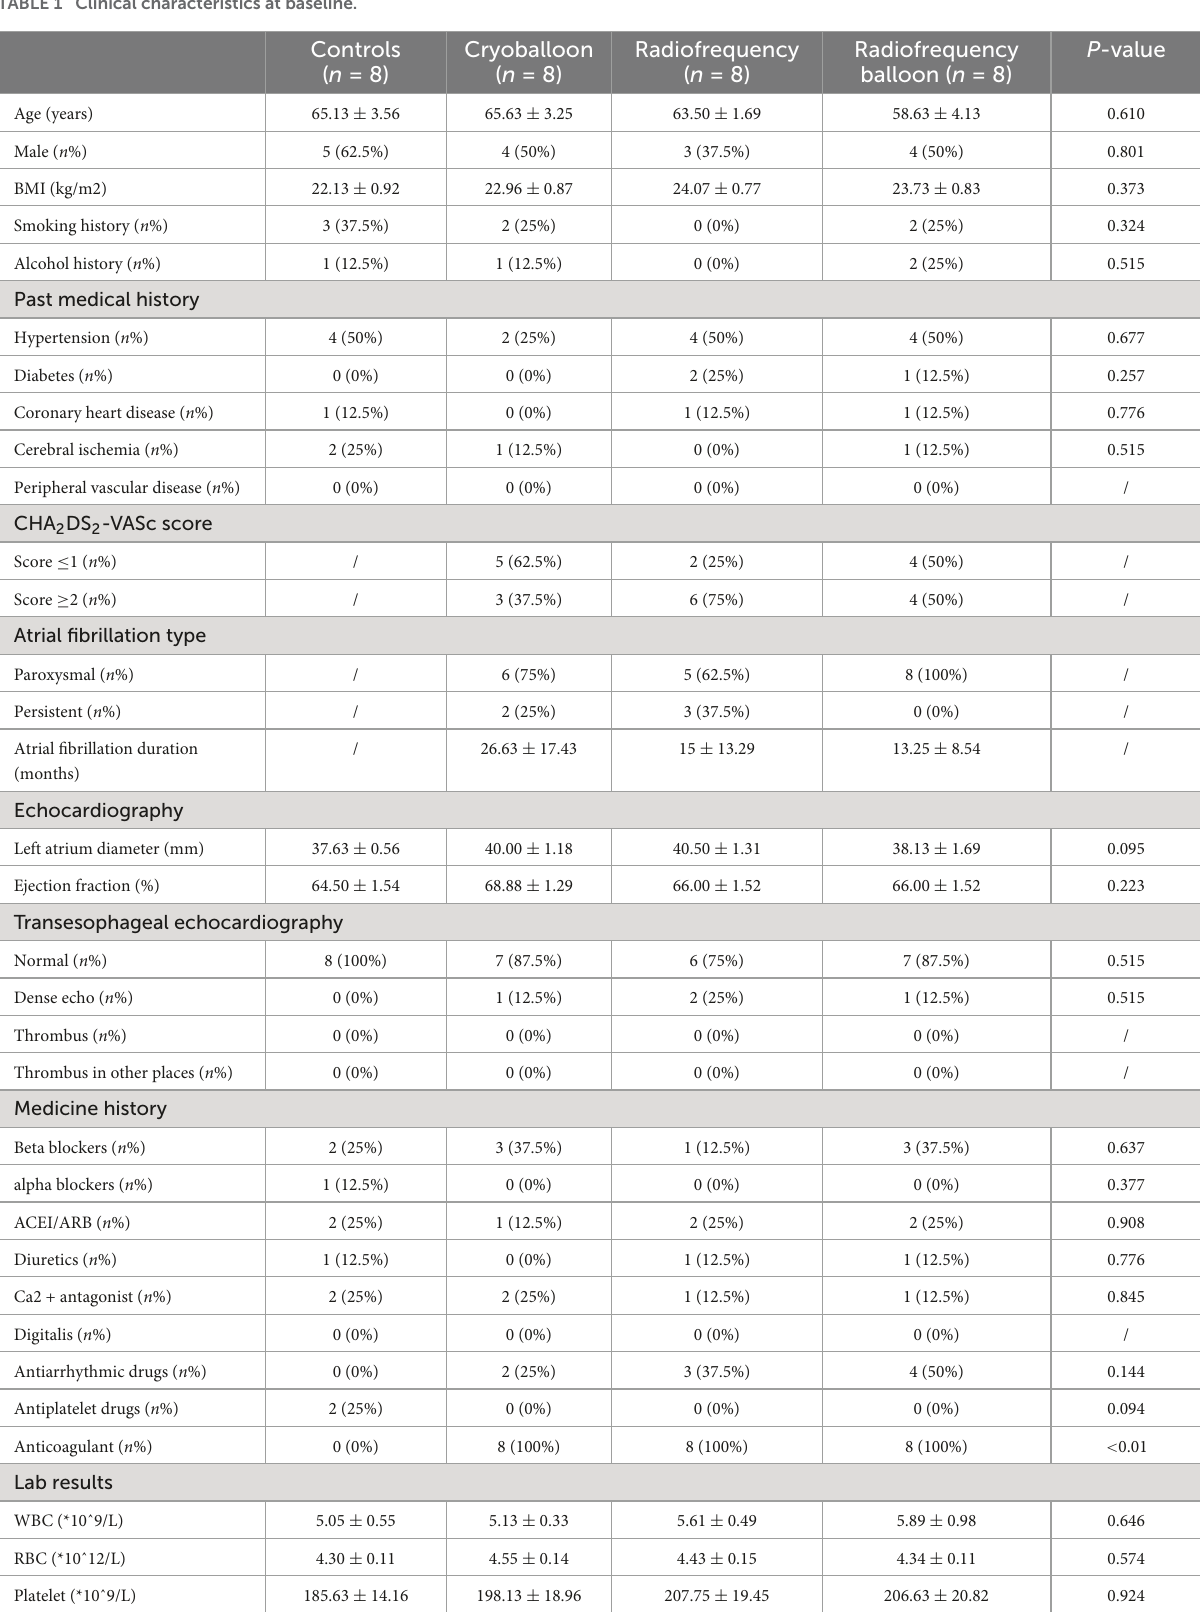
TABLE 1 Clinical characteristics at